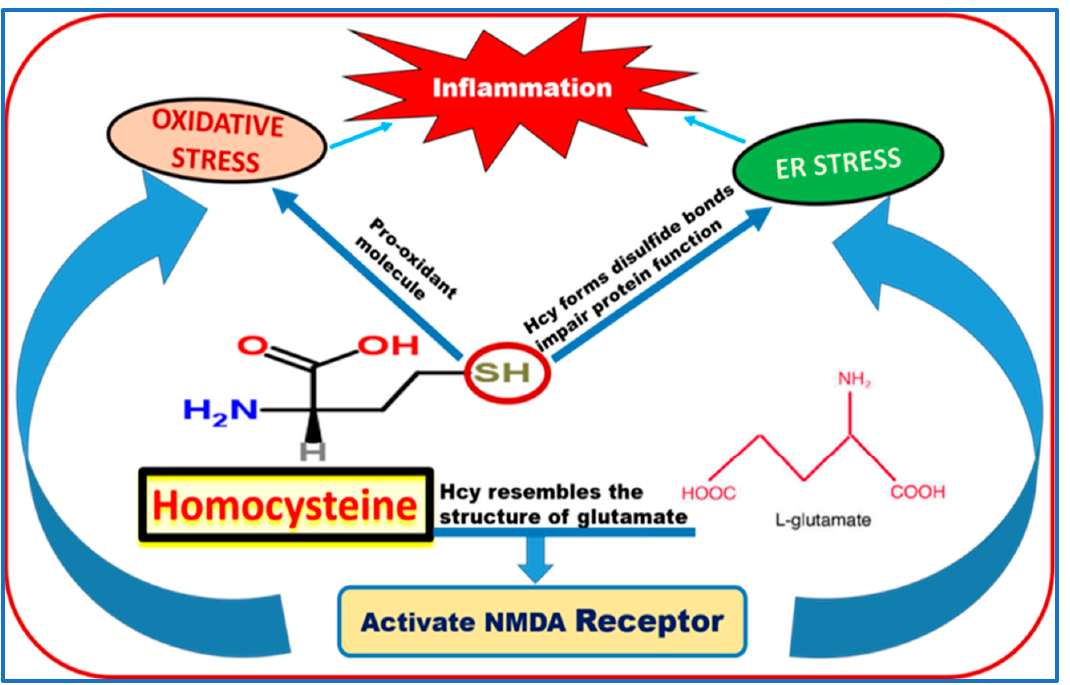
Figure 4. Suggested mechanisms of homocysteine induced harmful effects on retina and blood retinal barrier.